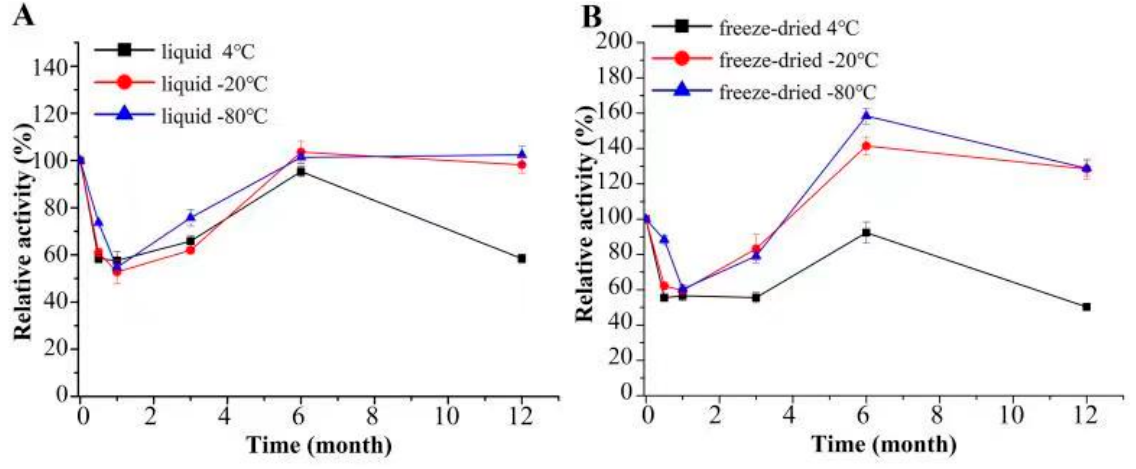
Figure 3. The storage stability of CcMan5C solution ( A ) or lyophilized CcMan5C ( B ).